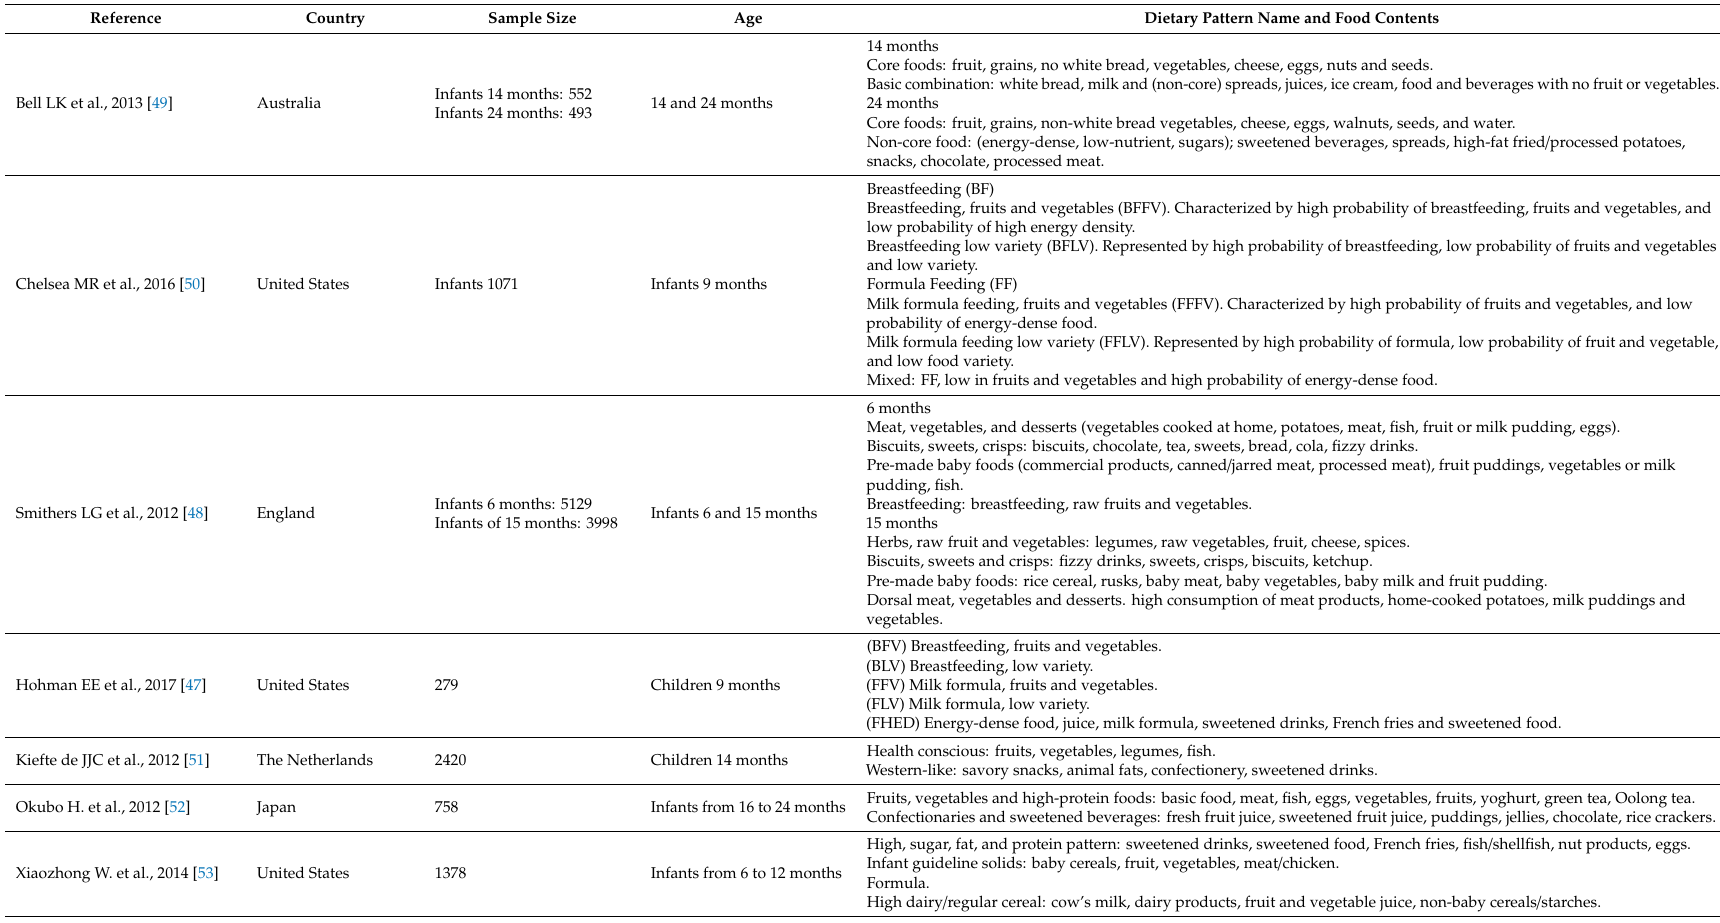
Table 1. Main characteristics of dietary patterns defined using an “a posteriori”